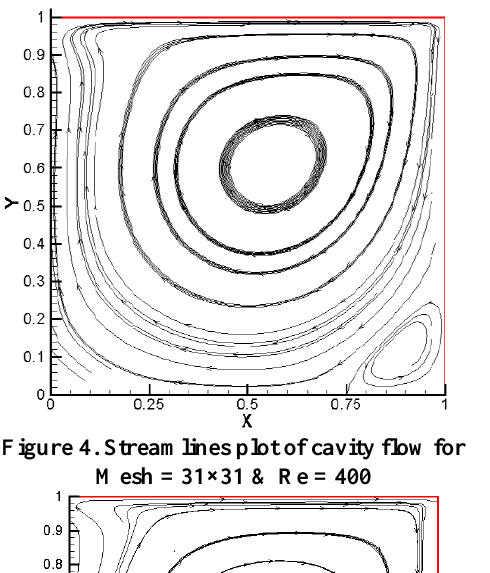
Figure 4. Streamlines plot of cavity flow for Mesh = 31×31 & Re = 400